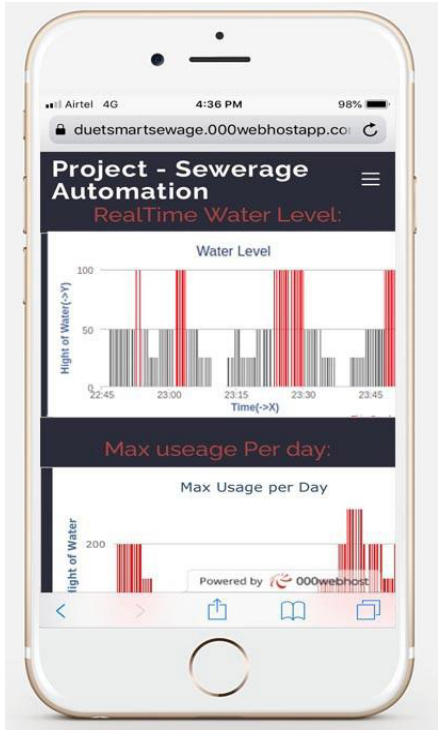
Figure 10. Monitoring through a web app on a mobile phone.